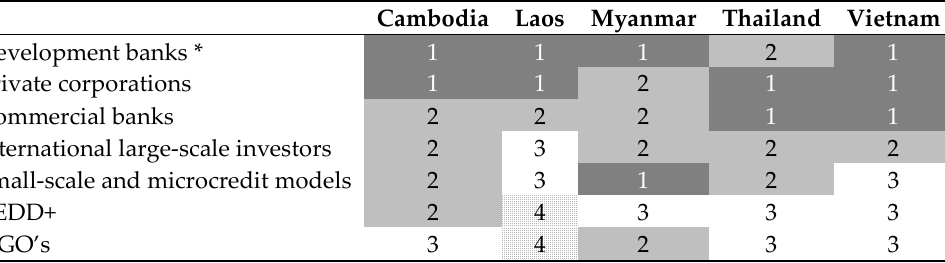
Table 6a. Short-term financing instruments of the proposed network, expressed by the ranked median values. 1 = very important, 2 = important, 3 = can be useful, 4 = not important. Background colors represent classes 1-3.